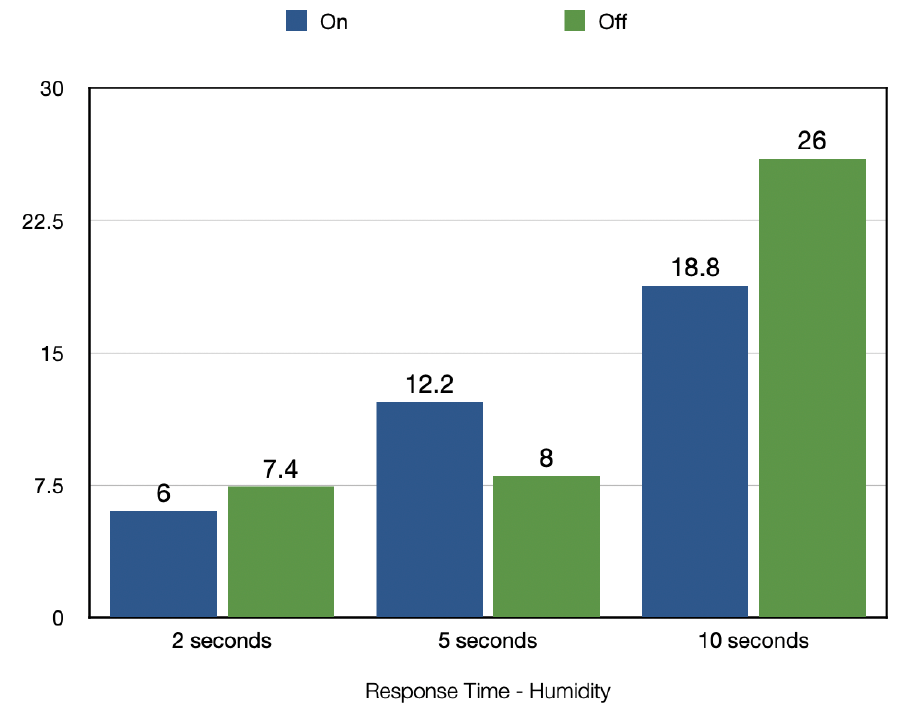
Figure 14. Visualization of Response